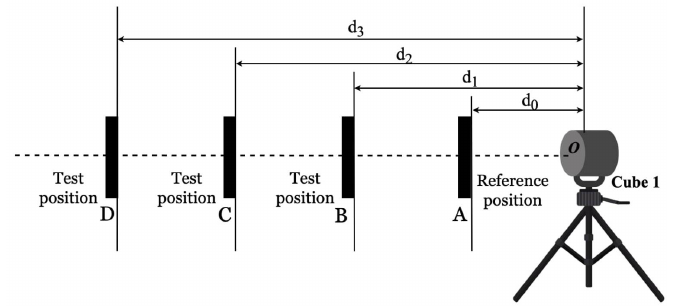
Figure 10. Layout of relative range test, source: adapted from